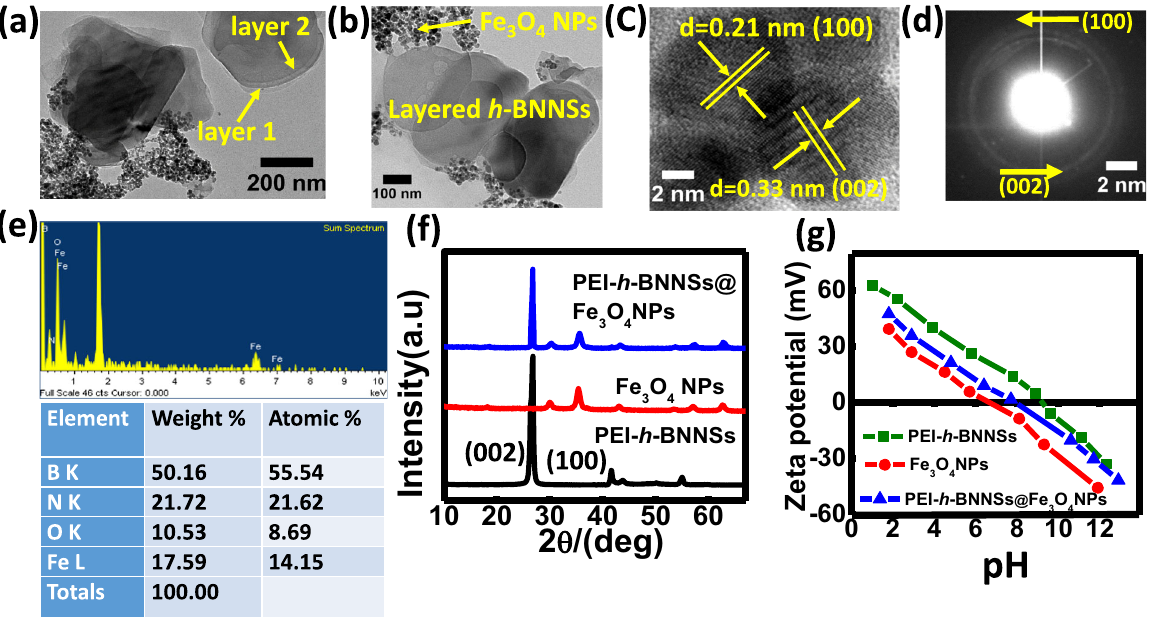
Fig. 3 Electron microscopic techniques, diffraction pattern and surface charge of the adsorbents. Characterization of the PEI- h - BNNSs@Fe 3 O 4 NPs: a , b Low-magni fi cation of TEM images, c high-resolution of TEM image, d SAED pattern, e EDS spectra/elemental composition, f XRD spectra (blue line), and g pH-dependent zeta potential (blue line). The black and red lines in ( f ) correspond to the XRD spectra of PEI- h -BNNSs and Fe 3 O 4 NPs, respectively. The green and red lines in ( g ) represent the pH-dependent zeta potentials of PEI- h -BNNSs and Fe 3 O 4 NPs, respectively.